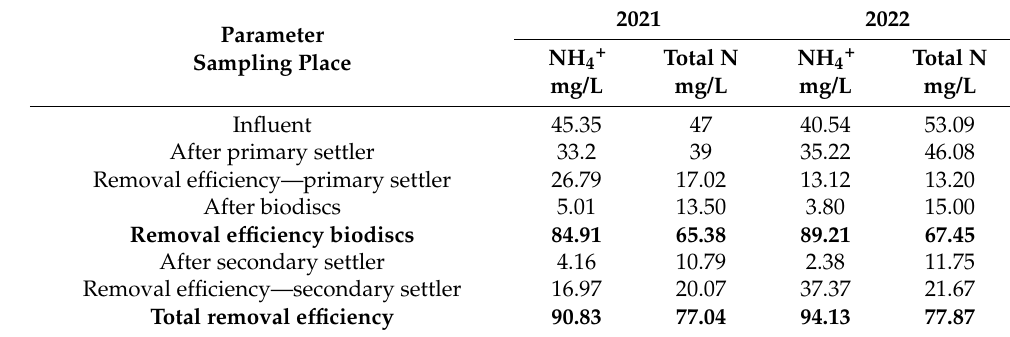
Table 5. Removal efficiency of the major equipment.